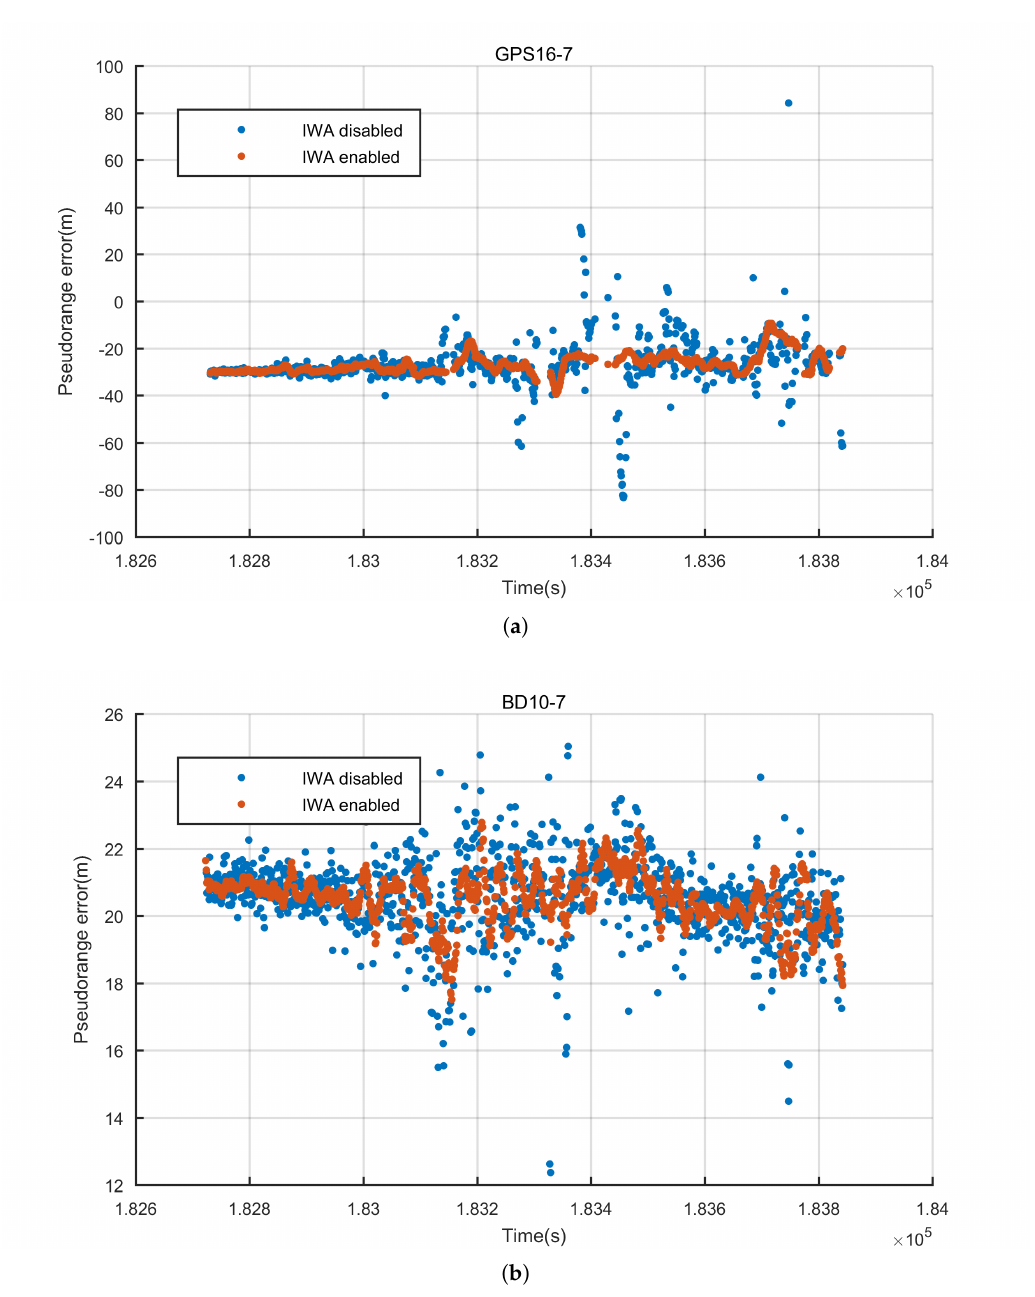
Figure 16. Pseudo-range error before and after applying INS aided weight control algorithm ( a ) Pseudo-range error comparison of GPS16 ( b ) Pseudo-range error comparison of